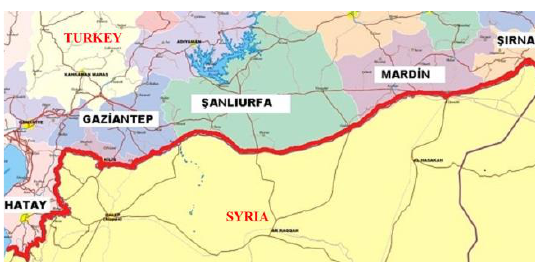
Figure 7. The borderline between Turkey and Syria (910km).